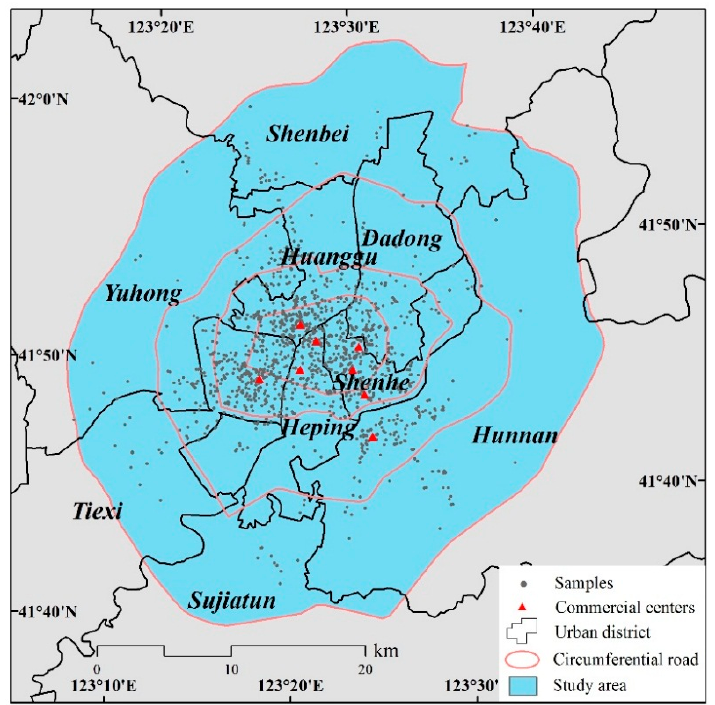
Figure 1. Map of study area.